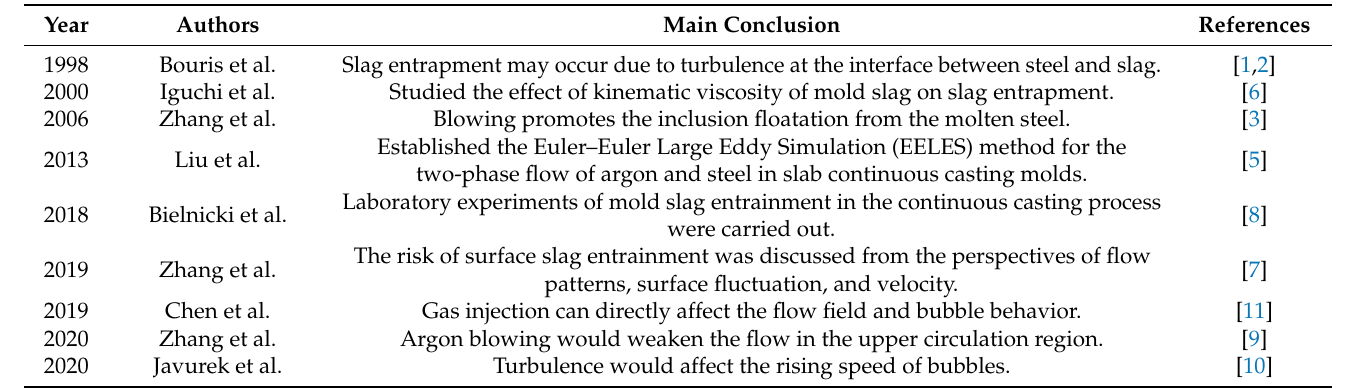
Table 1. Previous studies on multiphase